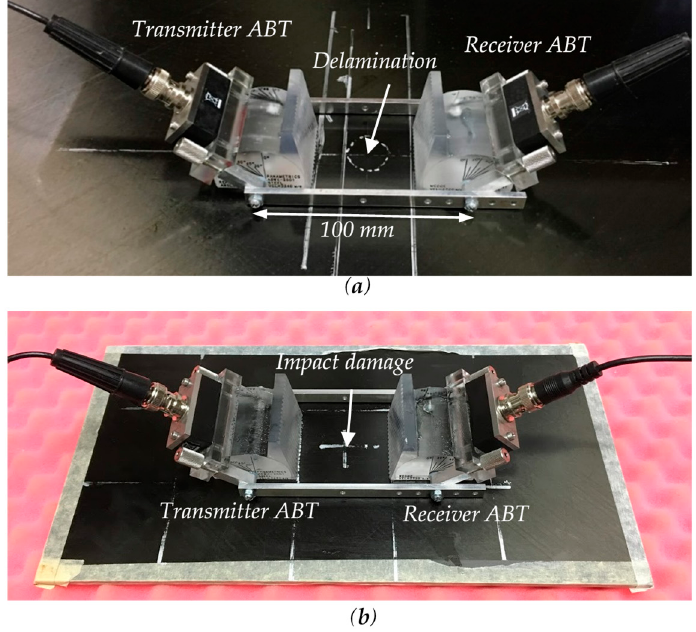
Figure 12. Experimental setup for damage detection using the ABT–ABT on a 2-mm quasi-isotropic CFRP composite plate: ( a ) delamination simulated by the Teflon insert; ( b ) impact damage.